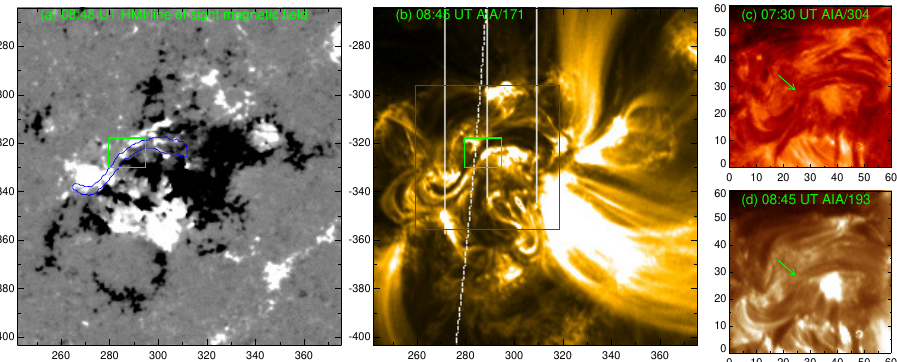
Figure 3. ( a ) The scale image is the line of sight magnetic field, with black for negative polarity and white for positive polarity. Blue contour outlines the profile of the filament in 171 Å image; ( b ) AIA 171 Å image shows the morphology of the active region. Three vertical lines show the filament slits, which were studied in detail in the following. Green squareness outlines the area where the initial EUV brightening occurred. White dotted line indicates the solar limb from STEREO-A point of view; ( c ) AIA 304 Å image of the filament as outlined by the red box in panel b; ( d ) AIA 193 Å image of the filament as outlined by the red box in panel